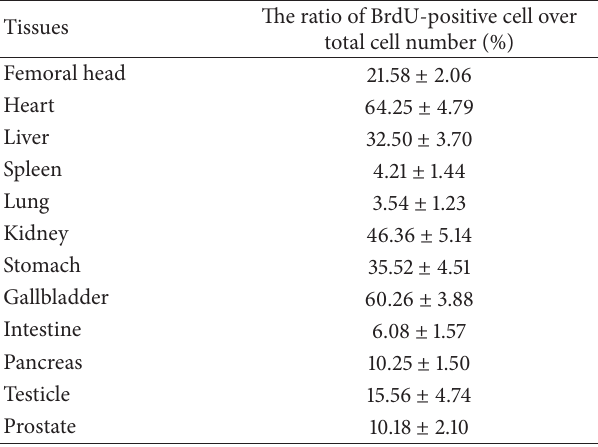
Table 1: The ratio of BrdU-positive cell over total cell number in different tissues at eight weeks after intra-arterial infusion of